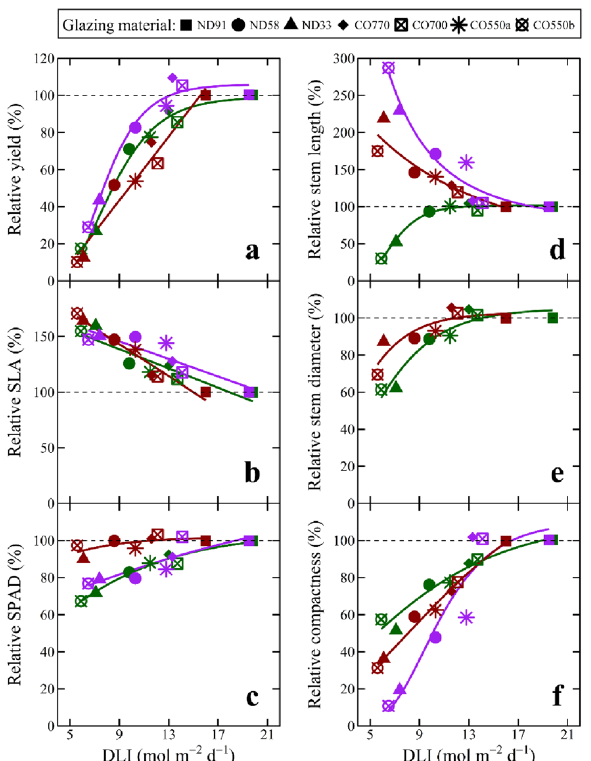
Figure 5. Relative growth response of basil, petunia, and tomato. Relative growth of basil (green symbols and regression lines), petunia (purple symbols and regression lines), and tomato (red symbols and regression lines) under various glazing materials with different spectral characteristics. The transmission spectra for the different glazing materials are given in Fig. 2. Each growth parameter is relative to the average value of the control treatment according to species and represents the average of ten samples. ( a ) Relative yield refers to basil and petunia shoot dry mass (leaves and stems) and tomato fresh fruit mass. ( b ) Specific leaf area ( SLA ) was calculated by dividing leaf area (cm 2 ) by leaf mass. ( c ) SPAD reflects the relative chlorophyll concentration of leaves. ( d ) Stem length was measured from the substrate surface to the apical meristem. ( e ) Stem diameter was measured at the substrate surface. ( f ) Compactness was calculated by dividing the total above-ground dry mass ( g ) by stem length